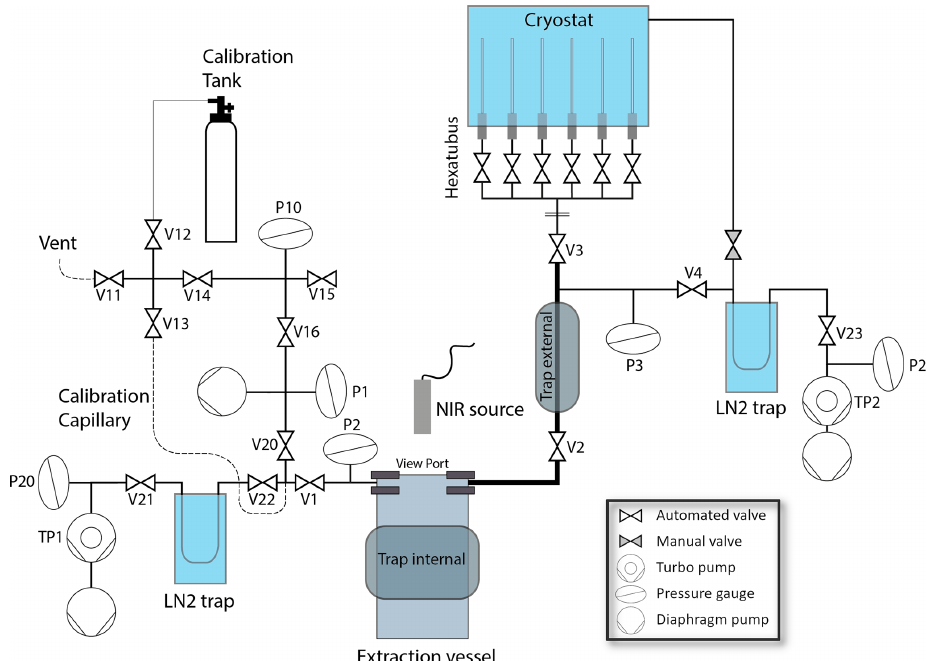
Figure 3. Schematic diagram of the laser-induced sublimation extraction (LISE) system. Tubing size upstream of V21 and V23 is mostly 1 / 4in., except in the sample pathway indicated by bold lines (3 / 8in.) and upstream of V12 (1 / 8in.). Individual components are described in the